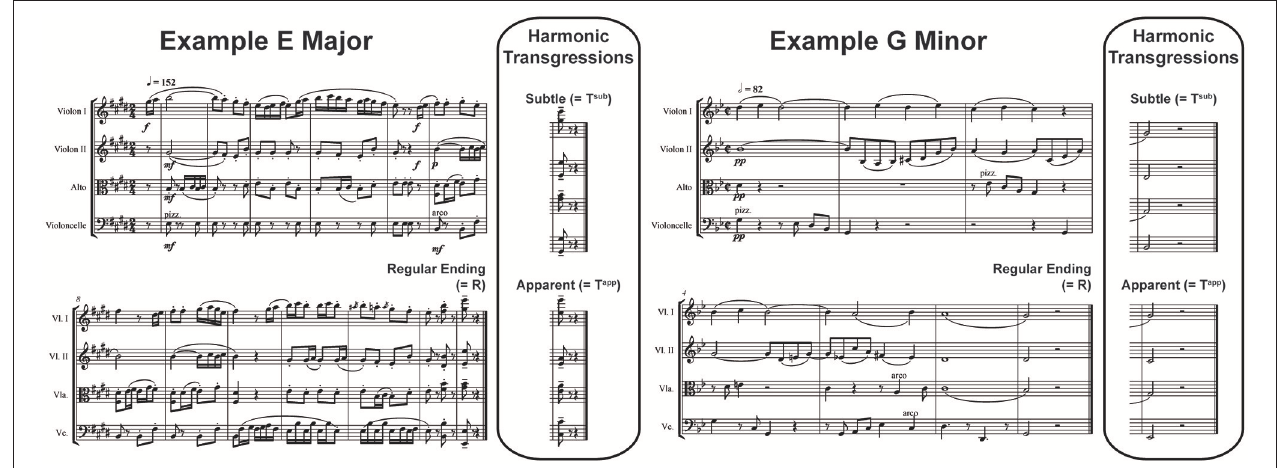
FIGURE 1 | Examples of Stimuli. A composition for string quartet in E major (Left) and another in G minor ( Right ; 2 out of 90 in total). Three versions of each were presented, each of which featured a Regular Ending (Tonic chord in root position), a Subtly Transgressed Ending (T sub ; Tonic chord in first inversion) or an Apparently Transgressed Ending (T app ; Subdominant in first